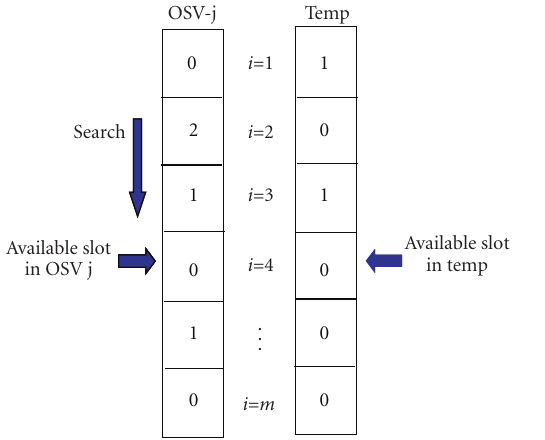
Figure 1: Assignment of a memory module for packets input in a given switch cycle.